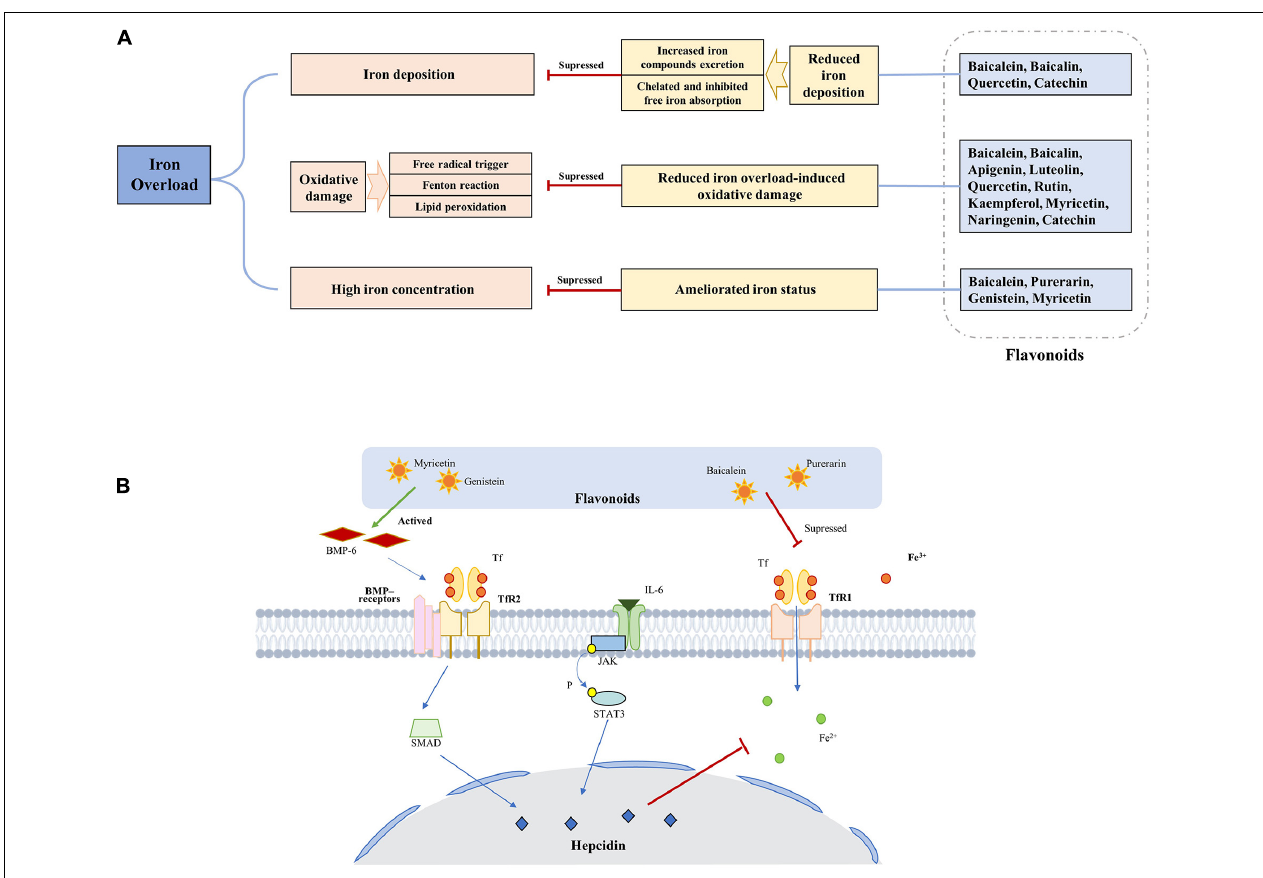
FIGURE 3 | Underlying mechanisms of flavonoids for treating iron overload. (A) The basic process of underlying mechanisms. (B) The main pathways of flavonoids can ameliorate iron